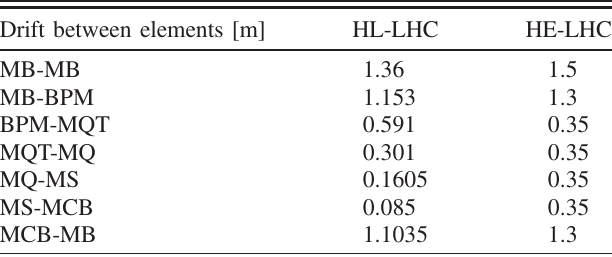
TABLE II. Minimum required element spacing for HL-LHC and HE-LHC